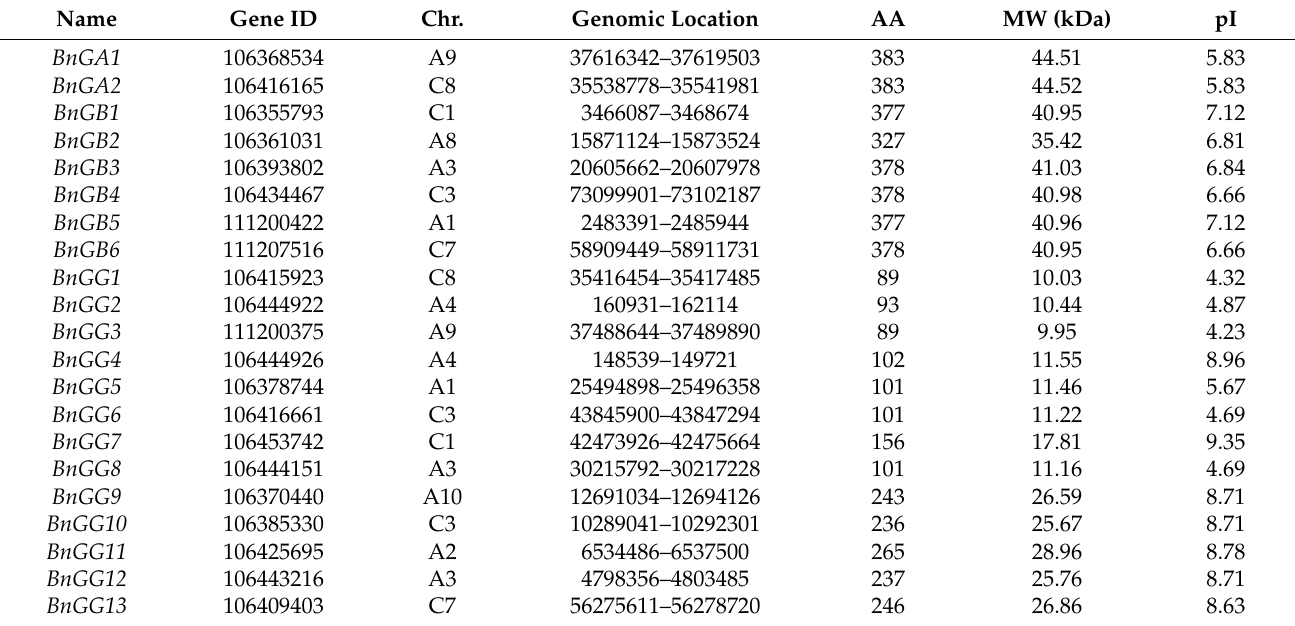
Table 1. Features of G-protein genes identified in B. napus